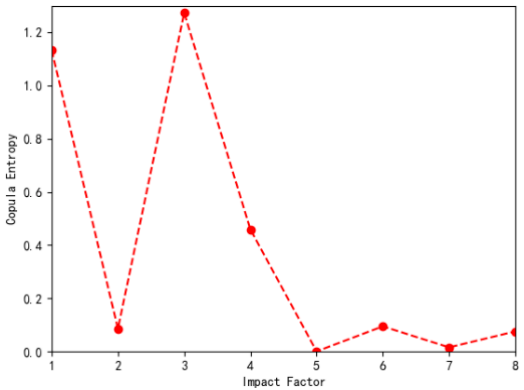
Figure 2. CE of each meteorological factor and PM2.5.